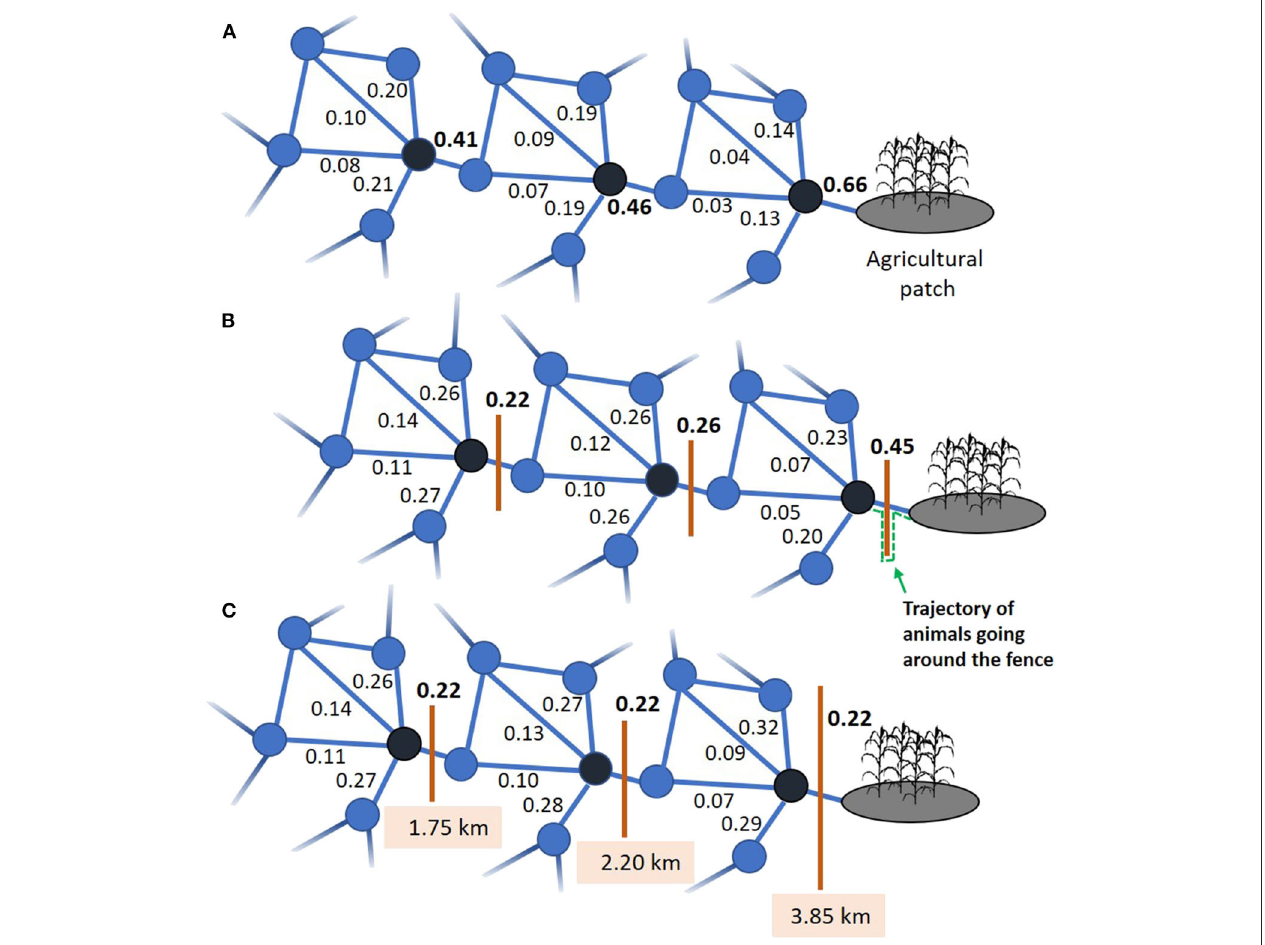
FIGURE 3 | (A) Subset of a trail network showing the relative probability of traveling from the three black patches to each of the five connected patches, as estimated from Equation (3). (B) Outcome on the relative probability of traveling the different trails from the black nodes, following the erection of fences (orange lines). The 1.75-km fences intersect the edges between two patches that are 1.1km apart, which imposes a 2.85-km path for an animal traveling between them while going around the fence, as illustrated by the dotted green line. (C) Fence lengths (1.75, 2.20, and 3.85km) required to maintain a probability of 0.22 that the animal travels between the two patches by going around the fence, given that movement taxis intensifies with proximity to the agricultural